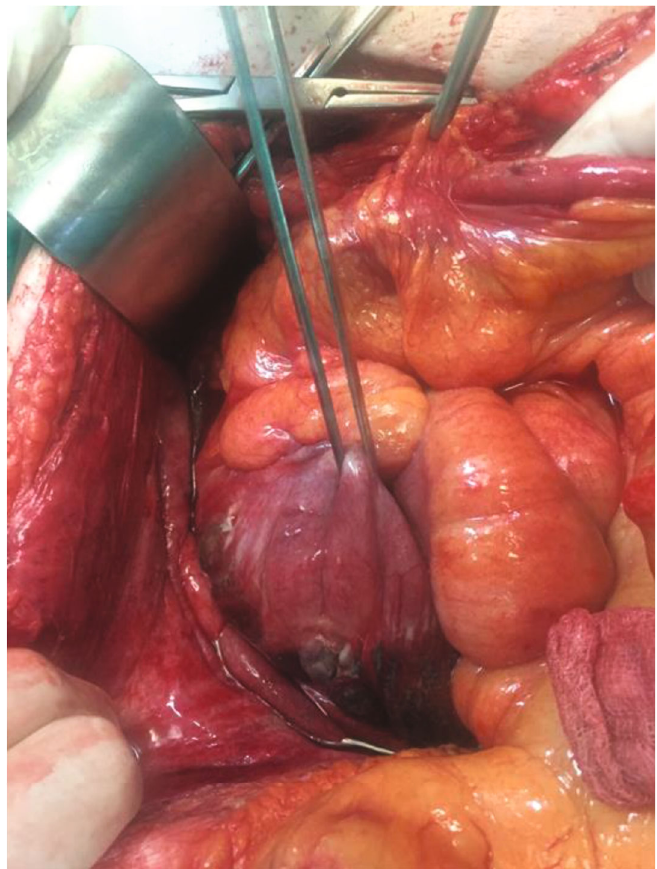
Figure 2: Exploratory laparotomy fi ndings. Peritoneal cavity appears without spillage, but there can be seen a retroperitoneal